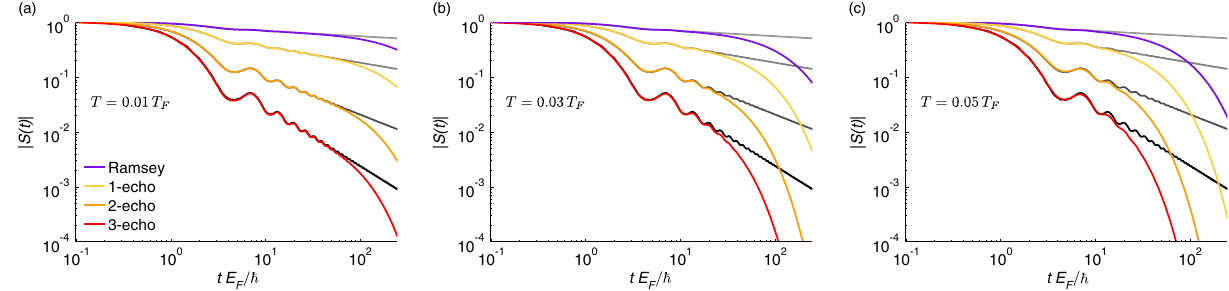
FIG. 7. The generalized spin-echo response, Eq. (21), of the Fermi gas for n ¼ 1 ; 2 ; 3 compared to the Ramsey interference. At long times, the generalized spin-echo response is characterized by a power-law decay, Eq. (22), with an exponent ð 4 n (cid:2) 1 Þ times larger than that of the standard OC. The gray lines correspond to T ¼ 0 , while the colored lines are for finite temperatures (a) T ¼ 0 : 01 T F , (b) T ¼ 0 : 03 T F , and (c) T ¼ 0 : 05 T F . The scattering length is k F a ¼ (cid:2) 1 : 5 in all cases. The power-law decay of the spin-echo response gives way to a faster exponential decay at times t * @ =T